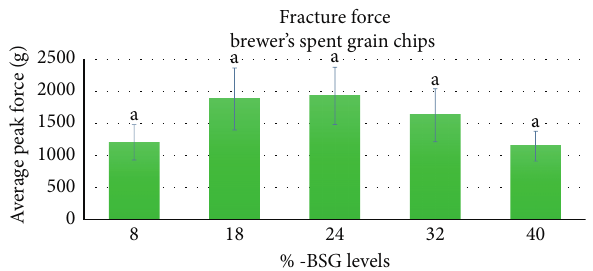
Figure 5: Three-point bend peak force of BSG chips made with varying levels of BSG inclusion. Values shown are mean ± S.D. n � 3 replications, with 10 subsamples per treatment. Columns accom- panied by the same letter have means that are not significantly different ( p ≤ 0 . 05).